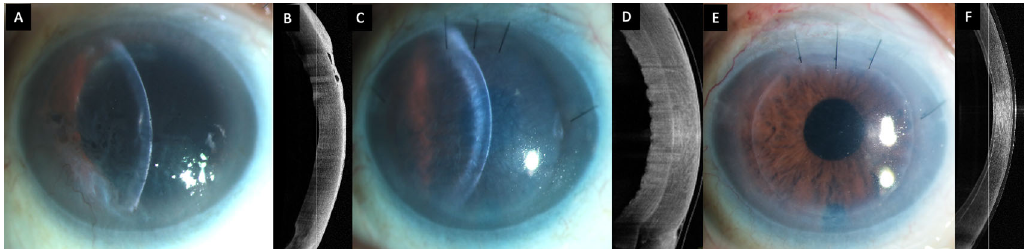
Figure 1. (A, B) Slit lamp image of the right eye at presentation depicting corneal edema with Descemet membrane folds and peripheral bullae which are also visible on the optical coherence tomography scan (OCT). ( C, D) Image captured one month after the Descemet stripping automated endothelial keratoplasty (DSAEK) showing primary graft failure with a well attached graft. (E, F) Clear cornea with an attached DSAEK lenticule 2 weeks after the repeat endothelial